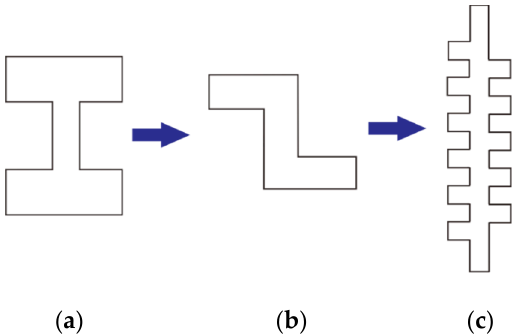
Figure 1. An improved design of zigzag unit. ( a ) A dumbbell-shaped structure; ( b ) Evolved into Z-shaped structure; ( c ) Strung together vertically into a periodical zigzag